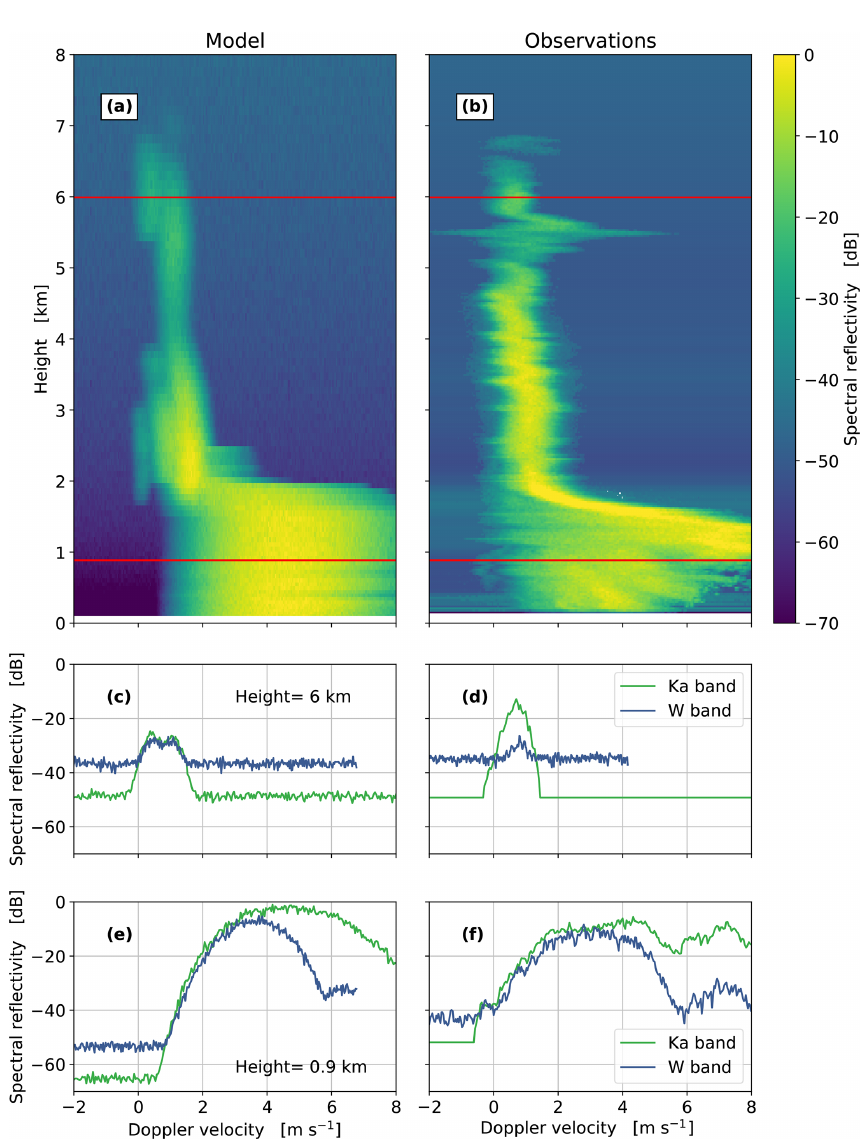
Figure 4. Comparison of simulated (a, c, e) and observed (b, d, f) Doppler spectra at 16:20 UTC for the same frontal case from 19 November 2015 shown in Fig. 3. From top to bottom: Ka-band spectrograms (a, b) ; example Ka- and W-band Doppler spectra in the ice (c, d) and the rain (e, f) parts of the cloud. The horizontal red lines in the spectrograms indicate the heights at which the example spectra of the successive panels have been